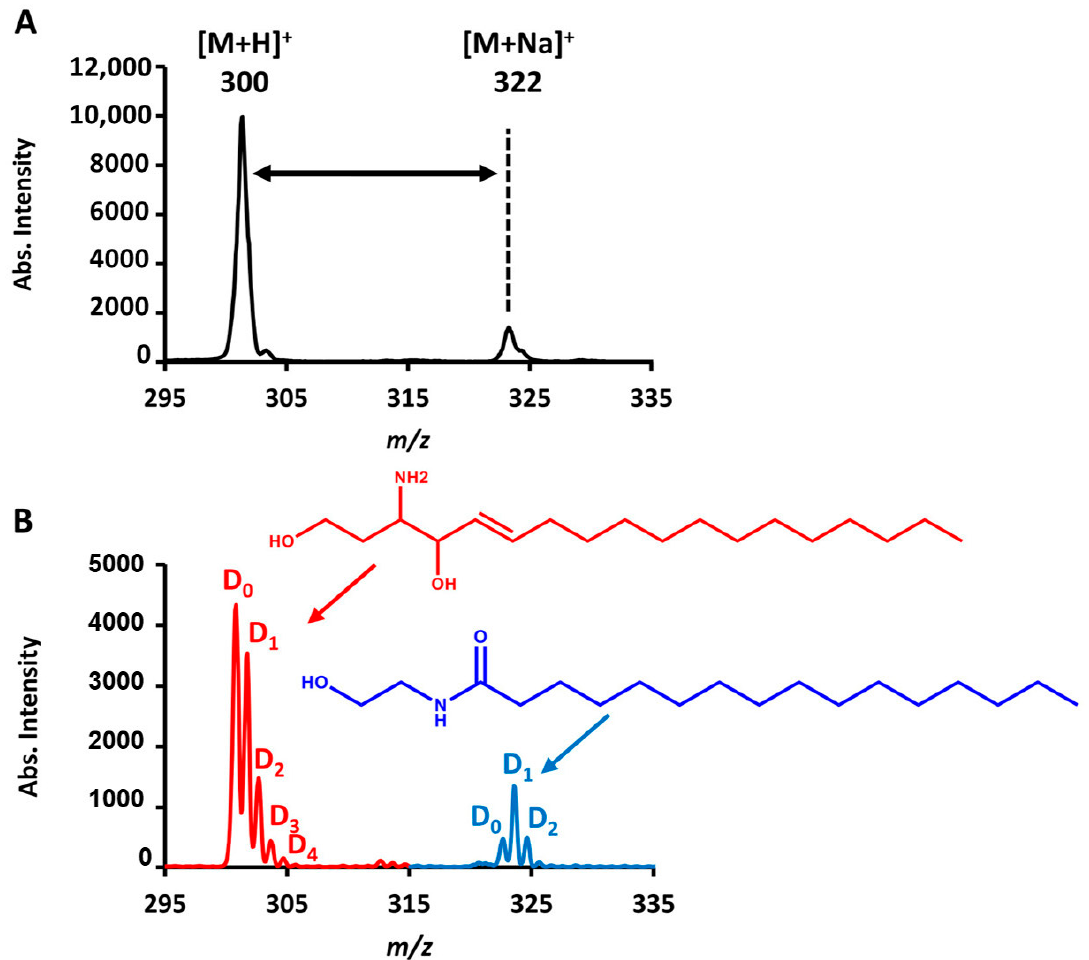
Figure 4. HDX–CPSI-MS for adduct ion differentiation. ( A ) Mass spectra of a pair of protonated and sodiated ions recorded by an LTQ mass spectrometer and ( B ) the distinguishing result for the pair of adduct ions, which are sphingosine (red, m / z 300, [M+H] + ) and palmitoylethanolamide (blue, m / z 322, [M+Na] +